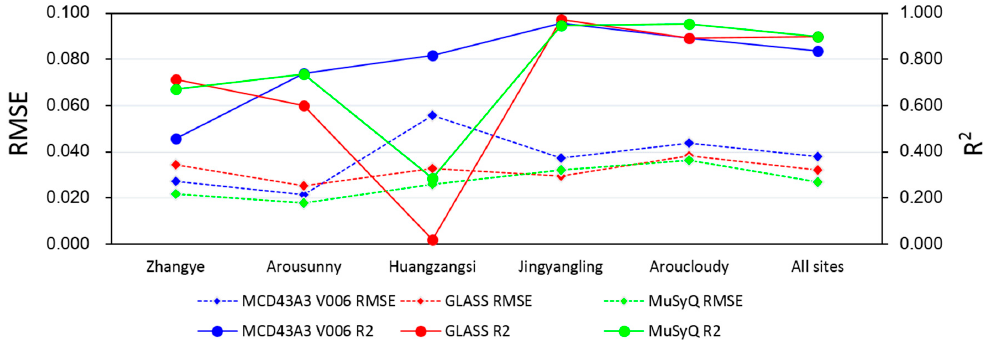
Figure 7. The comparisons of the RMSEs and R 2 between MCD43A3 (V006), GLASS and MuSyQ albedos from the multi-scale validation.